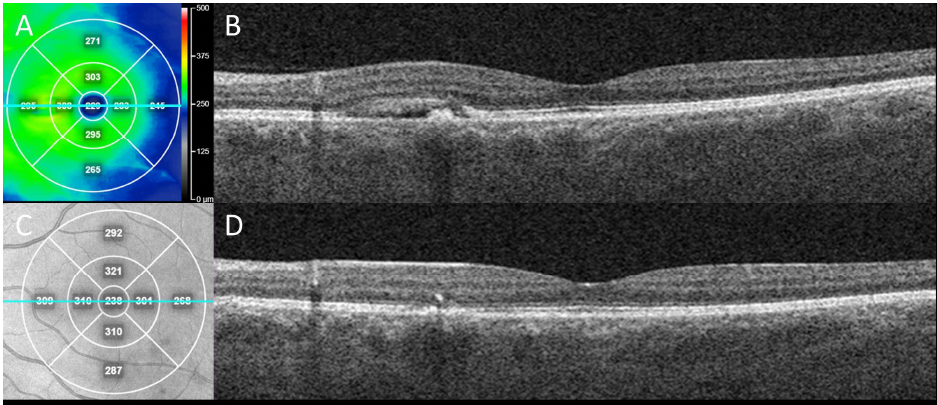
Figure 2. Clinical outcome from case in Figure 1 following treatment for CSCR with secondary neovascularization. En face swept-source OCT “heat” thickness map ( A ) with corresponding line (teal) OCT B-scan indicates subretinal fluid with RPE detachment in nasal macula of left eye at presentation ( B ) which alone could be mistaken for CSCR without neovascularization. This eye was treated with two sequential, intravitreal anti-vascular endothelial growth factor (VEGF) injections (bevacizumab), one month apart. Three months after initial presentation, en face near-infrared reflectance ( C ) with corresponding line (teal) OCT B-scan demonstrated sustained resolution of the subretinal fluid and collapse of the RPE detachment ( D ), consistent with response of exudation and neovascularization to anti-VEGF